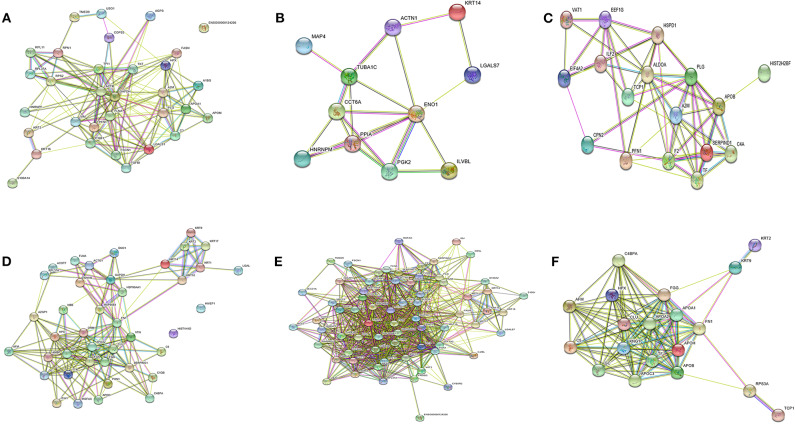
Protein-protein interaction networks. Protein-protein interactions of differentially expressed protein in different study groups. (A) Up regulated proteins in MAC PKDL patients compared to HI individuals. (B) Down regulated proteins in MAC PKDL patients compared to HI individuals. (C) Up regulated proteins in MAC PKDL patients compared to POLY PKDL patients. (D) Down regulated proteins in MAC PKDL patients compared to POLY PKDL patients. (E) Up regulated proteins in MAC PKDL patients compared to CR individuals. (F) Down regulated proteins in MAC PKDL patients compared to CR individuals. Purple and green colored lines for experimental and textmining evidence of different interactions.